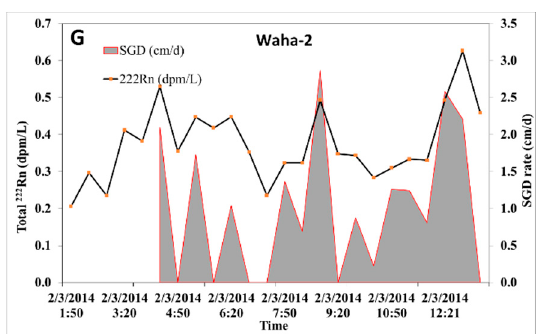
Figure 5. Radon in water and SGD rate in ( A ) Rafah, ( B ) Khan Younis, ( C ) Deir El Balah, ( D ) Zawaida, ( E ) Furosia, ( F ) Waha-1 and ( G ) Waha-2.